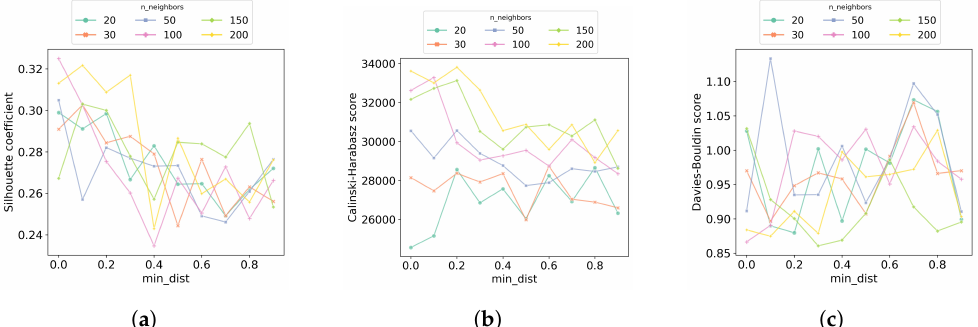
Figure 7. Increasing the number of neighbors leads to recovering better-defined clusters. In the first step of the hyperparameter tuning process for UMAP clustering, a grid search was performed to find the best combination of the number of neighbors ( n _ neighbors ) and distance ( min _ dist ). The number of clusters used for this search was set to 7. Each combination of ( min _ dist , n _ neighbors ) values was evaluated considering the clustering quality metrics ( a ) silhouette coefficient, ( b ) Calinski–Harabasz score, and ( c ) Davies–Bouldin score. For each plot, the horizontal axis shows the distance values ( min _ dist ) evaluated, the vertical axis shows the corresponding metric values, and the color code identifies the number of neighbors ( n _ neighbors )